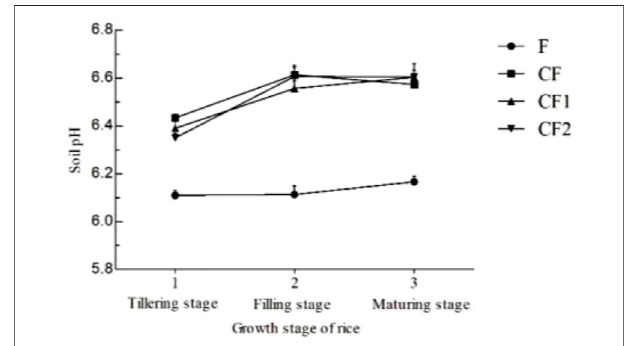
FIGURE 5 | Effect of co-application of biochar and chemical fertilizer on soil pH.